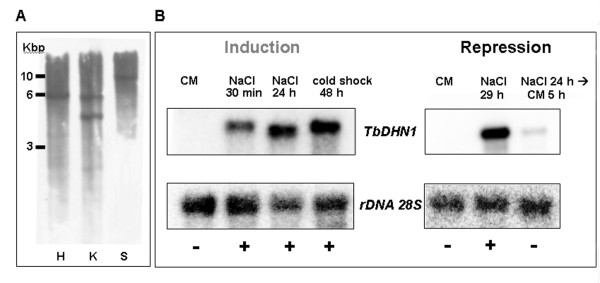
Panel A, Southern Blot analysis of TbDHN1. T. borchii genomic DNA digested with HindIII (H, Lane 1), KpnI (K, Lane 2) and SmaI (S, Lane 3) was probed with an ECL-labelled TbDHN1 cDNA probe. Panel B, Gel-blot analysis of the TbDHN1 transcript under salinity and low temperature stress. Induction (left): mRNA extracted from mycelia grown for 30 days on control medium (CM; Lane 1); treated for 30 min in NaCl 0.4 M (NaCl 30 min; Lane 2); treated for 24 h in NaCl 0.4 M (NaCl 24 h; Lane 3); treated for 48 h at 4°C (cold shock 48 h; Lane 4). Repression (right): mRNA extracted from mycelia grown for 30 days on CM (CM; Lane 1), treated for 29 h in NaCl 0.4 M (NaCl 29 h; Lane 2); treated for 24 h in NaCl 0.4 M and then transferred on CM for 5 h (NaCl 24 h→ CM 5h; Lane 3). Signals obtained by 32P -labeled TbDHN1 probe (top) were normalized using the rRNA 28 S probe as internal standard (bottom).